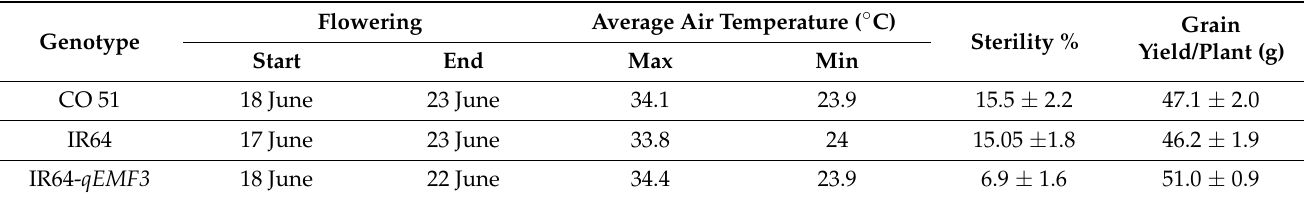
Table 1. Maximum and minimum temperature values recorded during the flowering period, spikelet sterility and the grain yields of CO 51, IR64 and IR64- qEMF3 varieties. Flowering Average Air Temperature ( ◦ C)